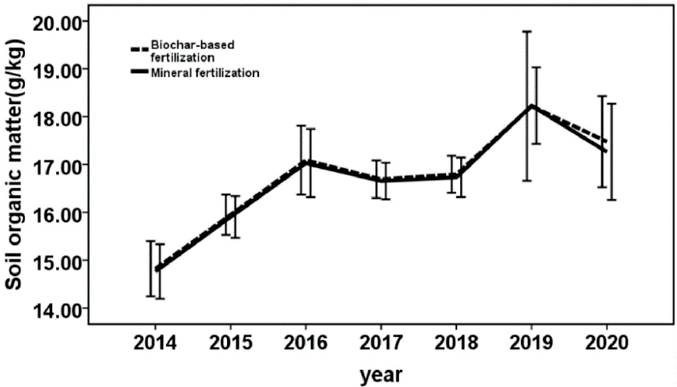
Figure 7. Soil organic matter (SOC) variation for fertilization treatment over 7 years.